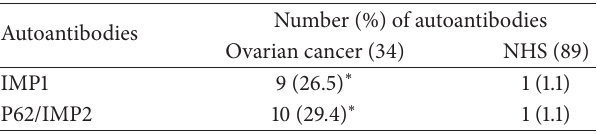
Table 1: Frequency of autoantibodies against IMP1 and p62/IMP2 in human sera by